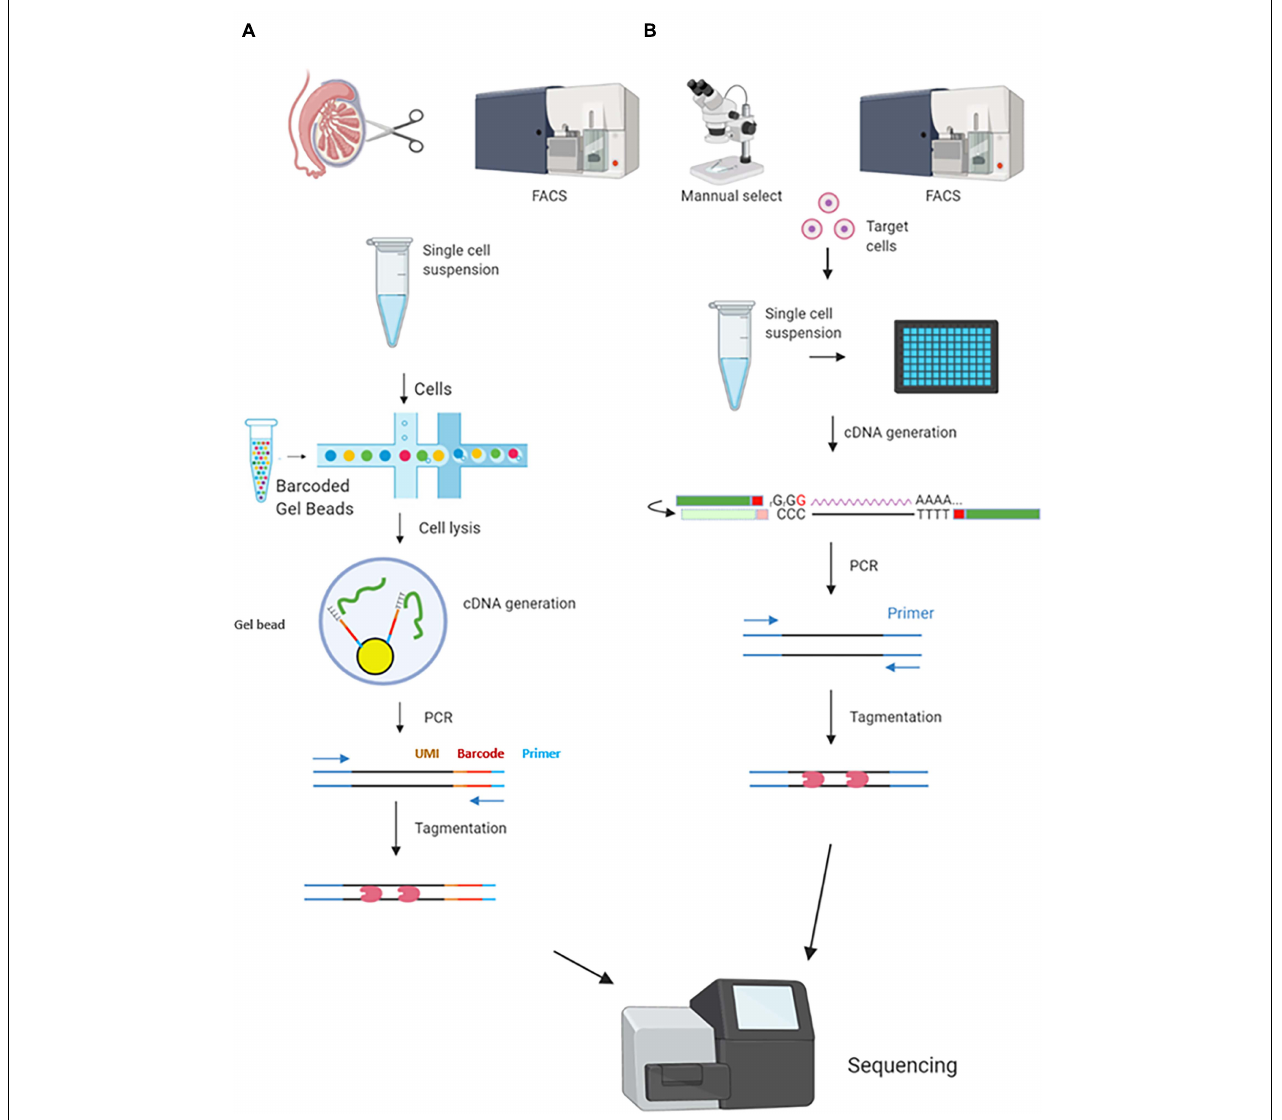
FIGURE 1 | Comparison between two scRNA-seq protocols commonly used in mammalian meiosis studies. Smart-seq2 and Drop-seq are the two most widely used methods in meiosis-related scRNA-seq studies. (A) Drop-seq allows a large sample size. A single-cell suspension is generated from testes or ovaries with or without cell sorting and enrichment, which depends on different research purposes. A single cell and a barcoded bead are encapsulated in each water-in-oil droplet. Cells are lysed to release mRNAs in the droplet and the mRNAs were captured by the bead with unique UMIs and barcodes. cDNAs are generated by reverse transcription and the templates were amplified, followed by library preparation. (B) Smart-seq2 starts with a small cell sample size. Cells can be collected by manual selection or FACS. Each individual cell is separated into different microtiter plate wells or microfluidics, cDNA will be generated for PCR and then be tagged for sequencing. The cDNA generation and amplification are similar to